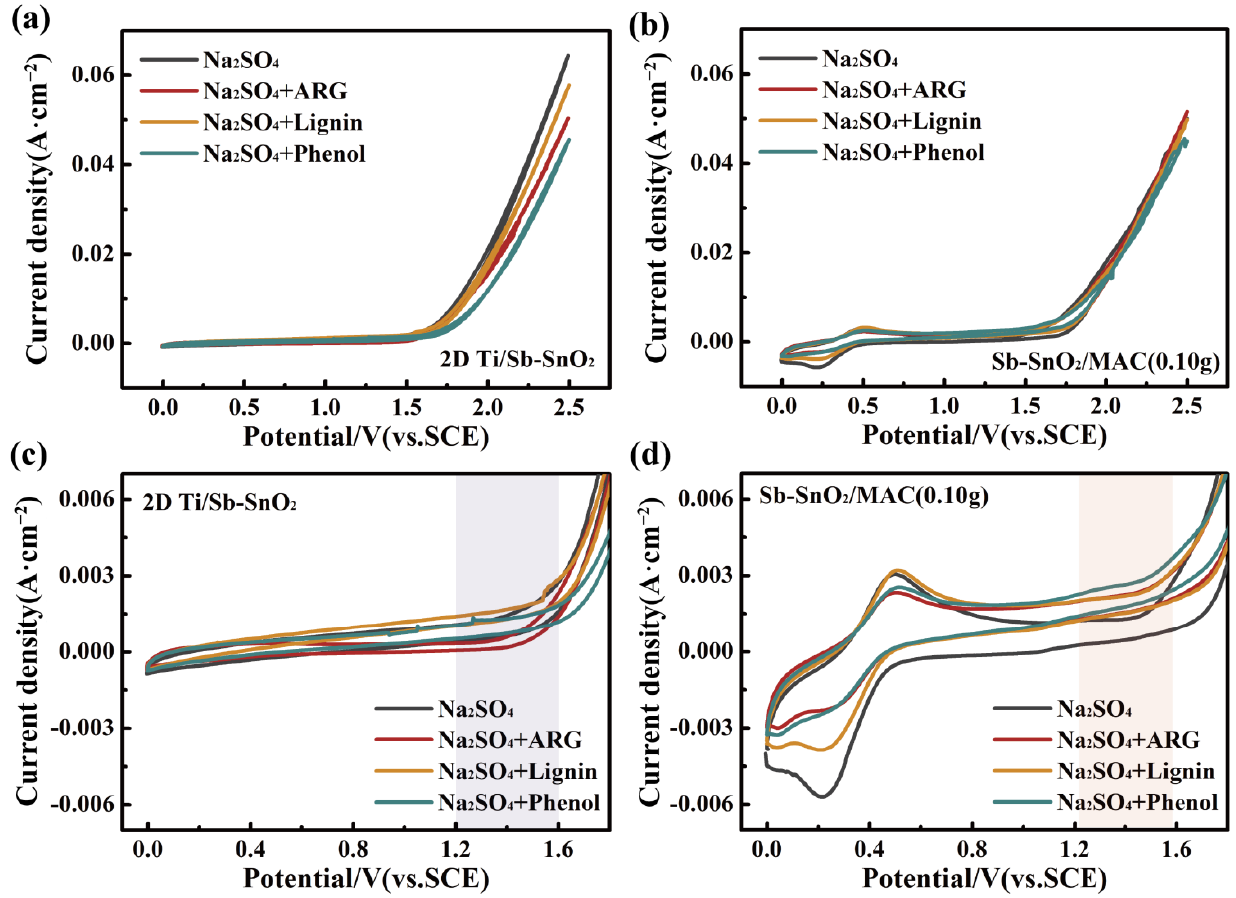
Figure 3. Normal CV curves of the electrodes (0–2.5 V (vs. SCE); scan rate: 0.01 V · s − 1 ) in 0.5 M Na 2 SO 4 solution and 0.5 M Na 2 SO 4 solution with 2000 ppm of ARG, lignin or phenol: ( a ) 2D Ti/Sb-SnO 2 ; ( b ) Sb-SnO 2 /MAC(0.10 g); ( c ) Partial enlarged view of 2D Ti/Sb-SnO 2 ; ( d ) Partial enlarged view of Sb-SnO 2 /MAC(0.10 g).